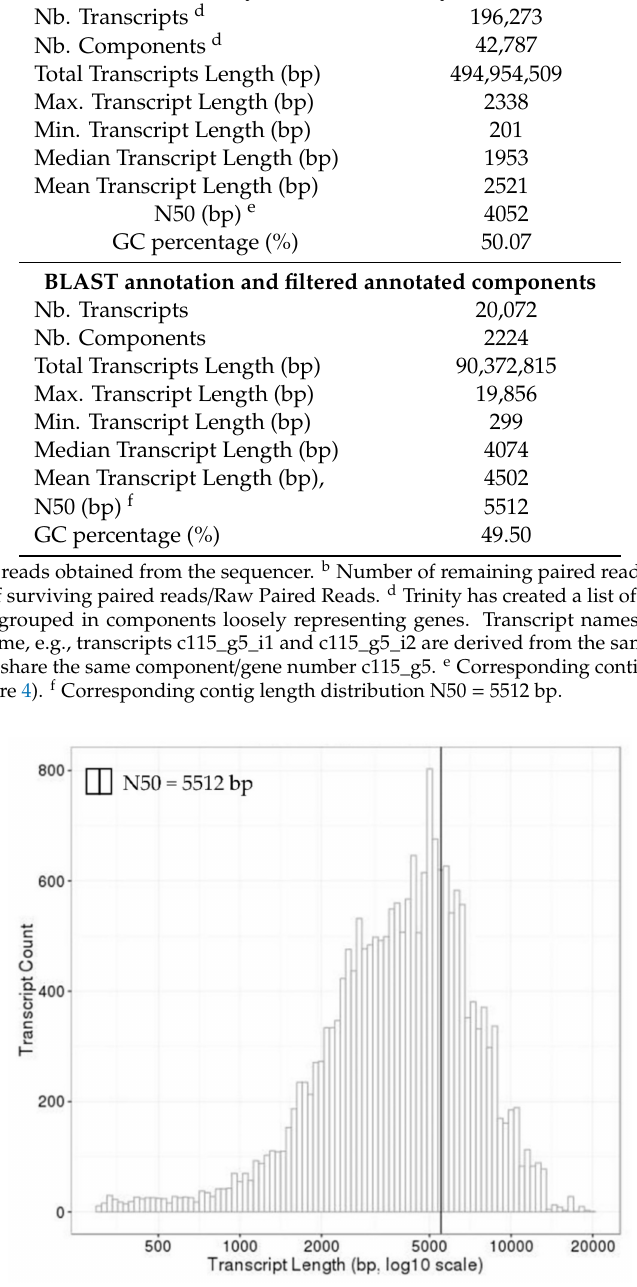
Figure A2. Sequence length distribution of transcripts of I. obliquus after Trinity de novo